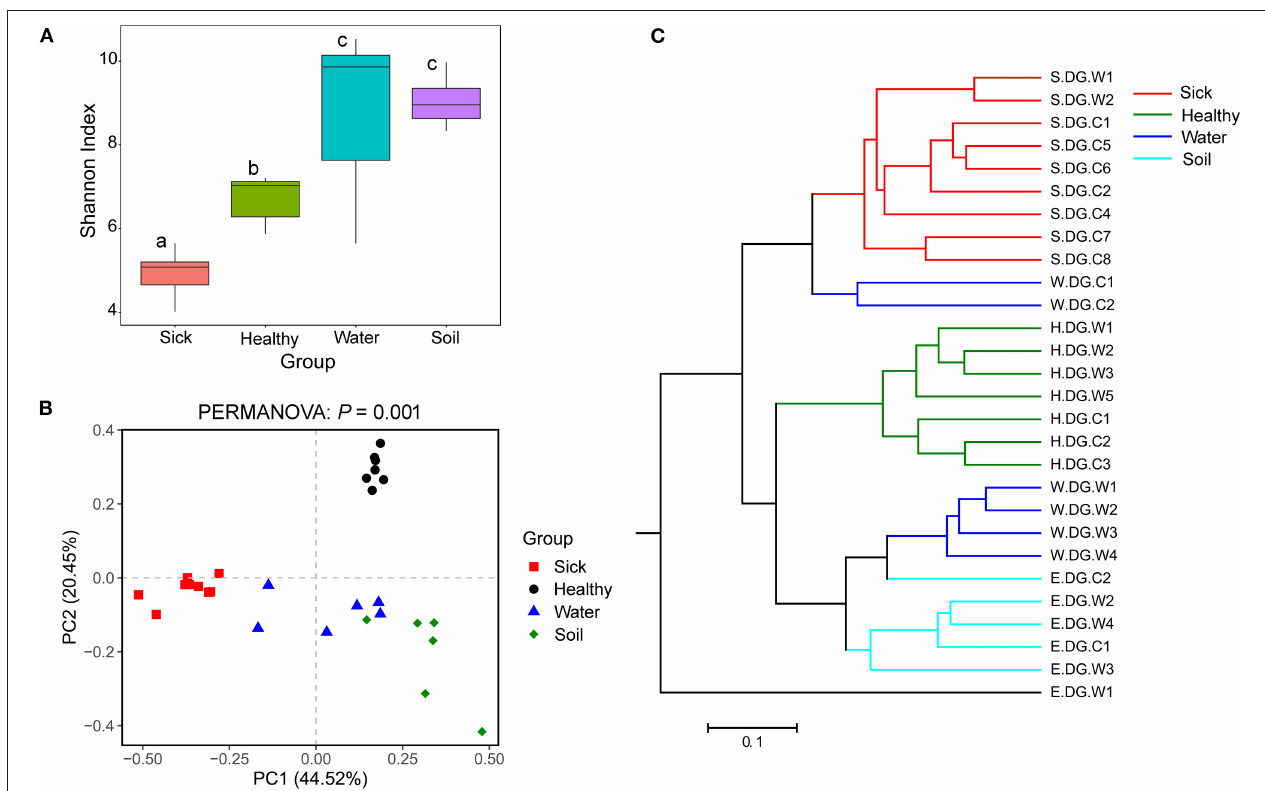
FIGURE 4 | Community diversity of the cutaneous bacterial microbiome. (A) Alpha diversity indicated by Shannon index. Data with different superscript letters are significantly different ( P < 0.05) according to Wilcoxon test. (B) Beta diversity indicated by principal coordinate analysis (PCoA) and based on the weighted UniFrac distance matrix. Numbers inside the parenthesis in the axis label show the percentage variation explained by each PC. P -value of PERMANOVA test is noted at the top of PCoA plot. (C) Beta diversity indicated by the UPGMA cluster and based on the weighted UniFrac distance matrix.